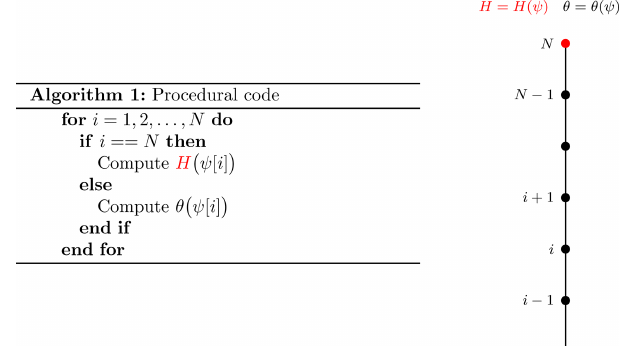
Figure 5. Adopting a procedural approach, the computation of the equation states is hard-wired into the code. The behaviour of each control volume is determined by an if-else statement according to the position of the element in the grid. In this case the properties of the grid, here the equation state, are joined with the topology. Here the nonlinear function V (ψ) is replaced with either H(ψ) or θ(ψ) according to the position of the node. To keep the pseudocode short, H(ψ) and θ(ψ) stand for all the nonlinear functions used in the NCZ algorithm, and the method f stands for one of the methods defined in the EquationState class.